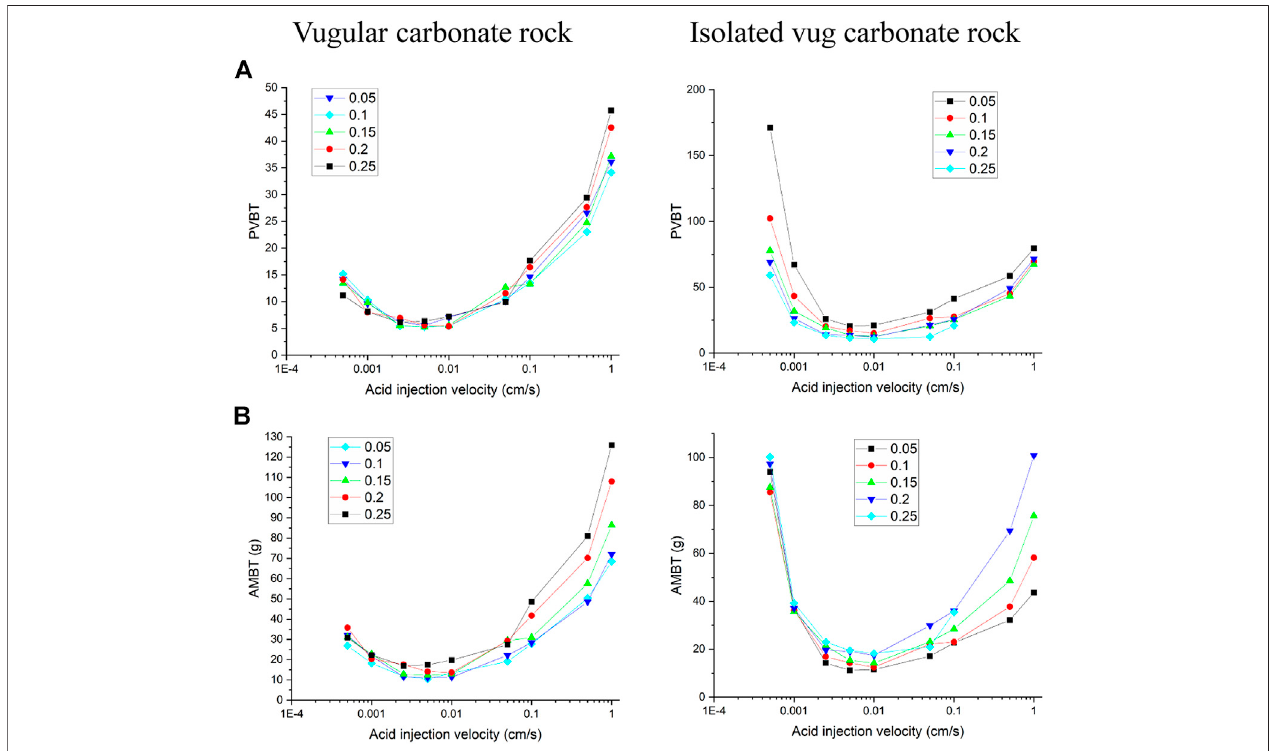
FIGURE 14 | Effect of matrix porosity on the acidizing results: (A) pore volume to breakthrough (PVBT) and (B) acid mass to breakthrough (AMBT).